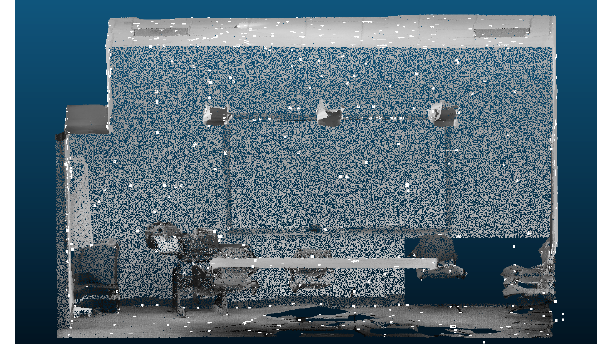
Figure 3. Feature pre-processing. Harris key points are selected and shown in the white point. The raw point clouds are shown in the gray scale.